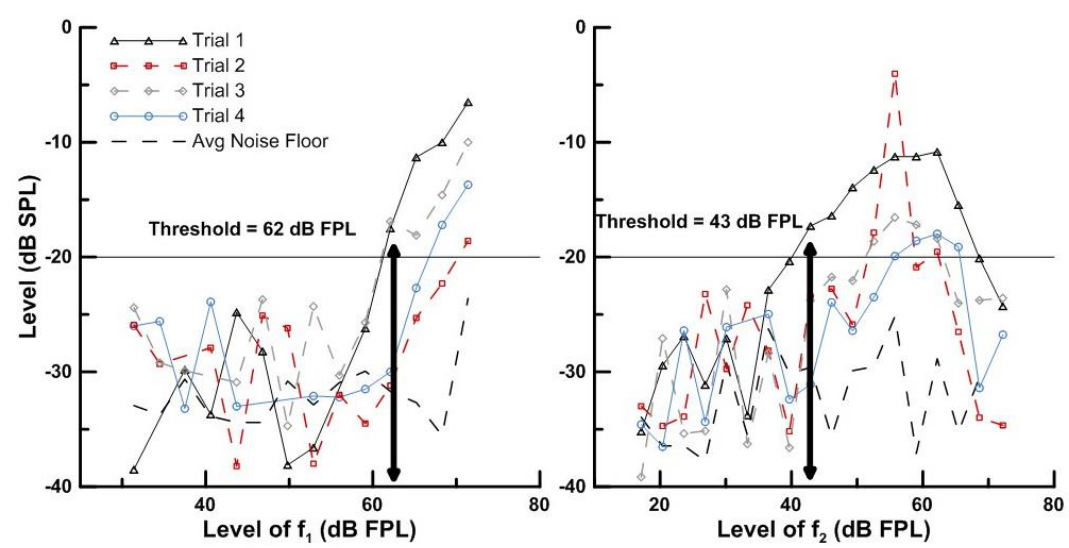
Figure 2. Detection thresholds at the second highest frequency with a present DPOAE (6.6 kHz) for patient 7. The left panel depicts the input–output (I / O) function when L 1 is varied in 3 dB steps (L 2 = 57, L 1 = 27–67 dB FPL) and the right panel shows the results when L 2 is varied in 3 dB steps (L 1 = 57, L 2 = 17–67 dB FPL). Black triangles 1, red squares 2, grey diamonds, and blue circles indicate sessions 1 through 4, respectively. The thin dashed black line indicates the average noise floor for all four sessions. Vertical arrows indicate the detection threshold identified at the baseline session. Sessions and trials are